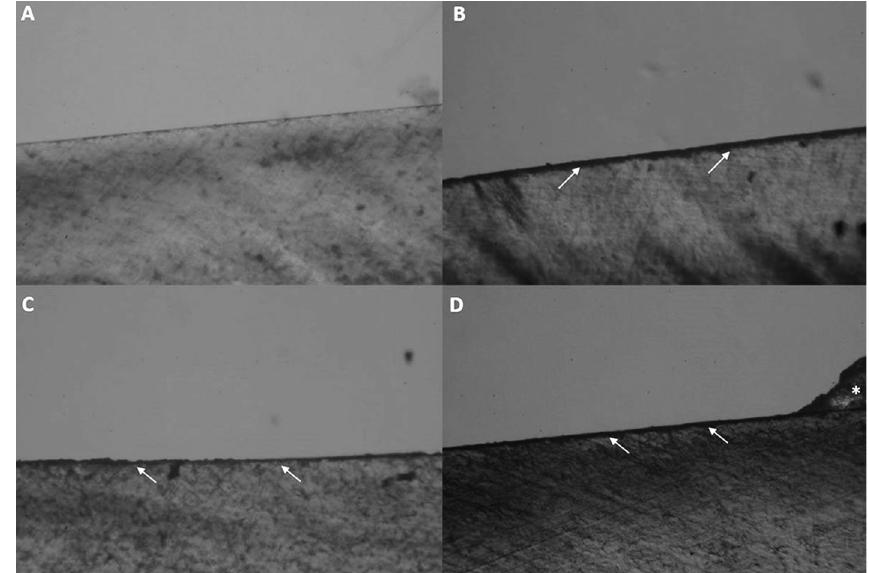
Figure 4- Polarized Light Microscopy images (10x). (A) Sound enamel. (B) Enamel demineralization in control; (C) NaF varnish; (D) and NaF solution groups. ( → ) Enamel demineralization. (*) Remaining resin left on enamel after shear bonding test